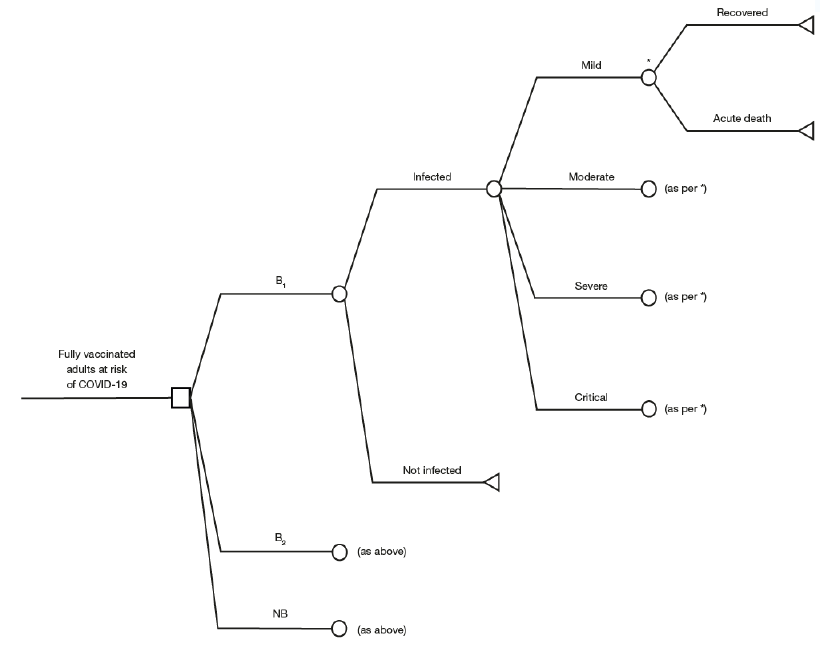
Figure 1. Decision tree model structure. The star above the probability node (upper right) is indicat- ing the structure tree at the right side of the node that can be copied. The star in between brackets in the other nodes signals that this structure is copied at that node.